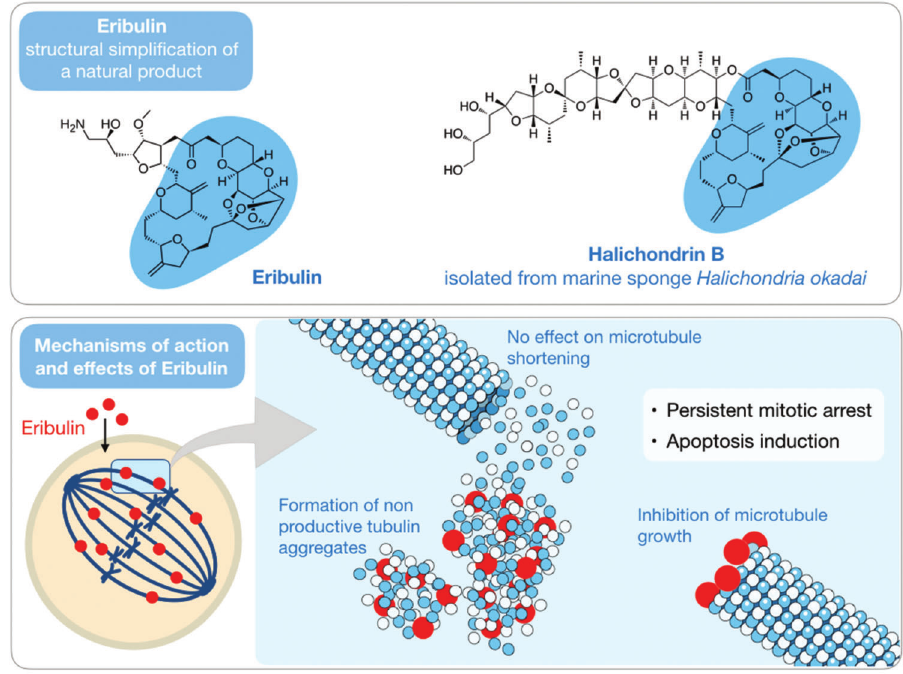
Figure 3 - Chemical structures of eribulin mesylate and the related natural product halichondrin B isolated from the sponge Halichondria okadai (top). A schematic representation of the mechanism of action of eribulin mesylate in cancer cells